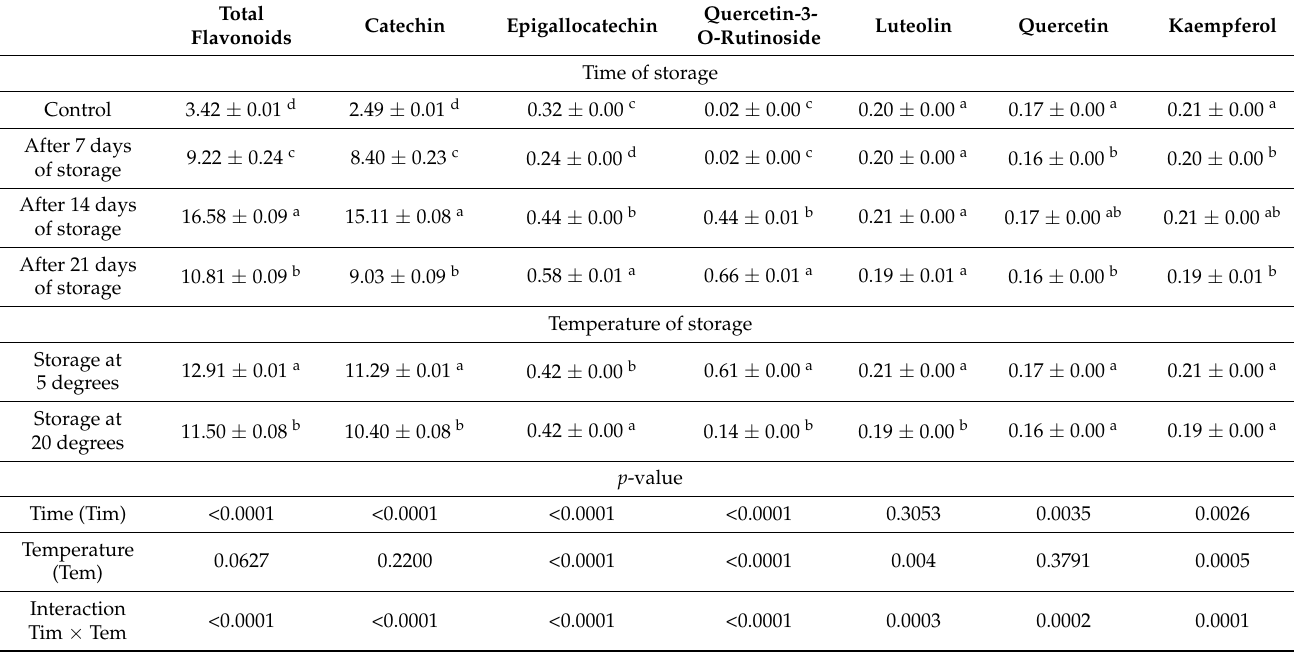
Table 5. The content of total flavonoids and individually identified flavonoids in apple (in mg/100 g FW). Total Quercetin-3- Catechin Epigallocatechin Luteolin Quercetin Kaempferol Flavonoids O-Rutinoside Time of storage